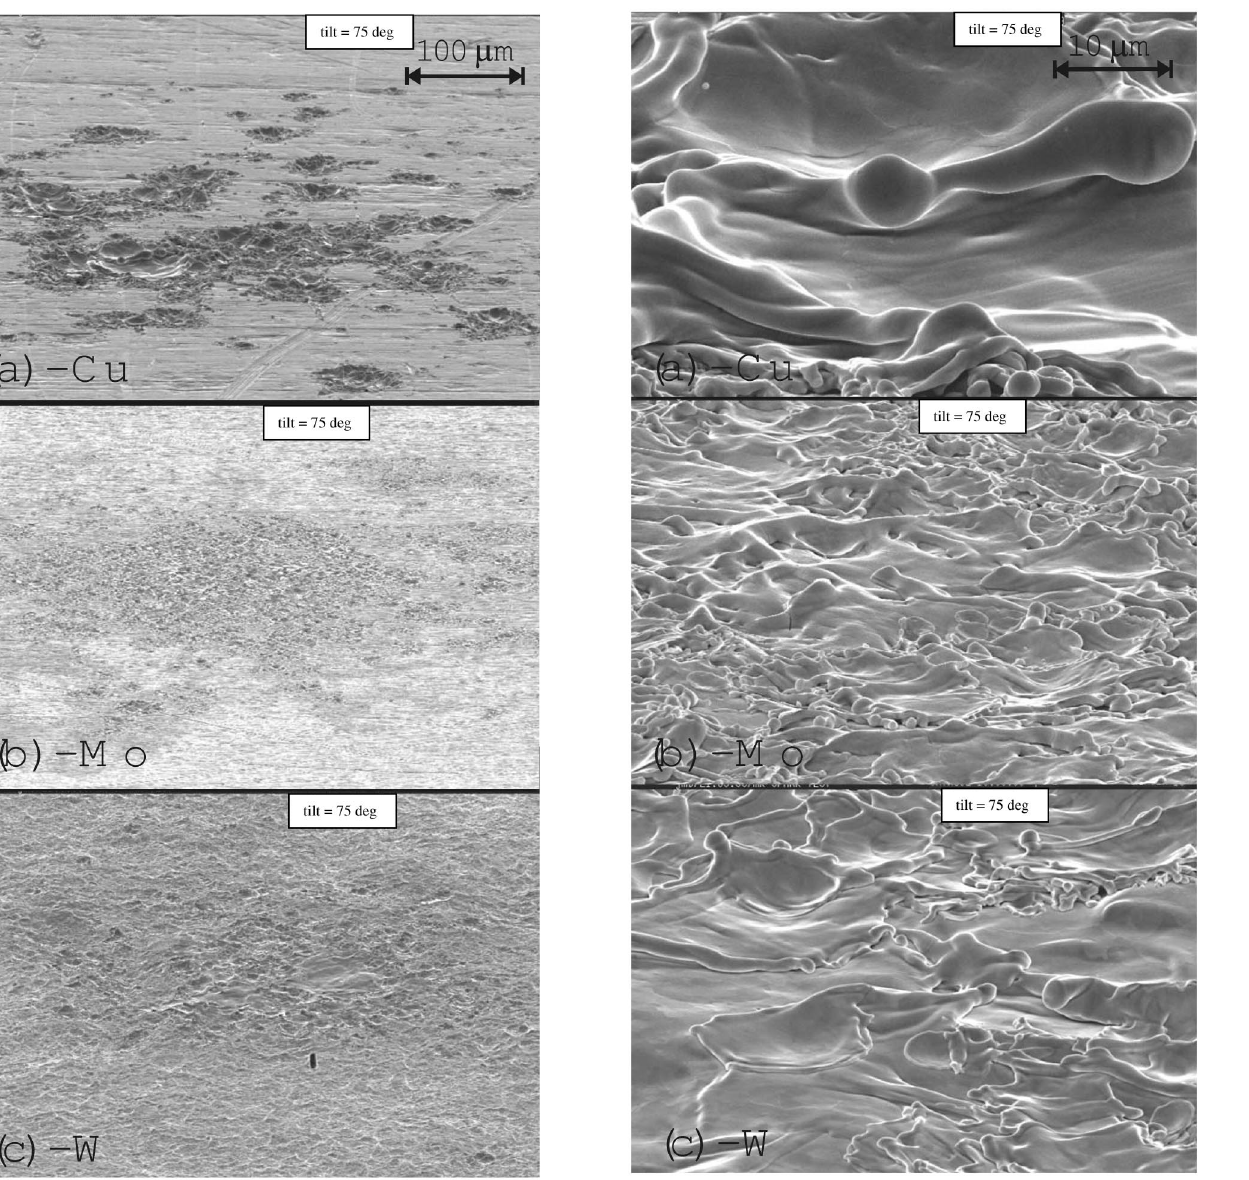
FIG. 6. Scanning electron microscope (SEM) images of the Cu (a), Mo (b), and W (c) cathodes at the position where a conditioning curve has been measured. The magnification was 250, and the tilt angle was 75 (cid:4) . The arrow shows 100 (cid:14) m .